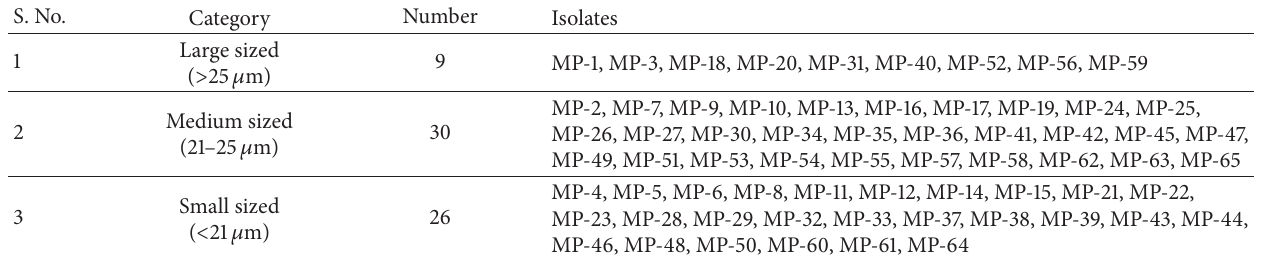
Table 4: Categorization of M. phaseolina isolates on the basis of size of sclerotia.